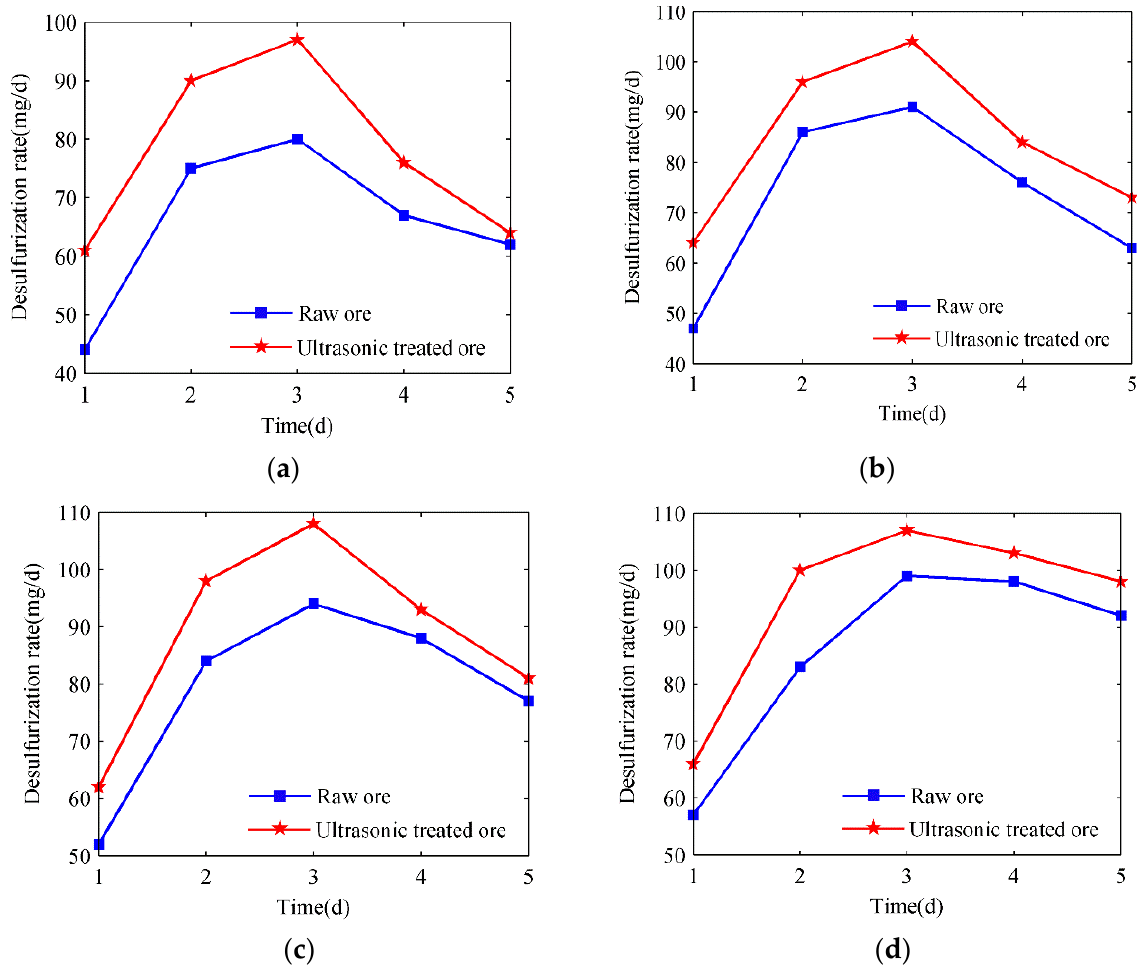
Figure 7. Comparison of the desulfurization rate with time for different particle sizes: ( a ) 60–80 mesh; ( b ) 80–100 mesh; ( c ) 100–120 mesh; ( d ) 120–140 mesh.